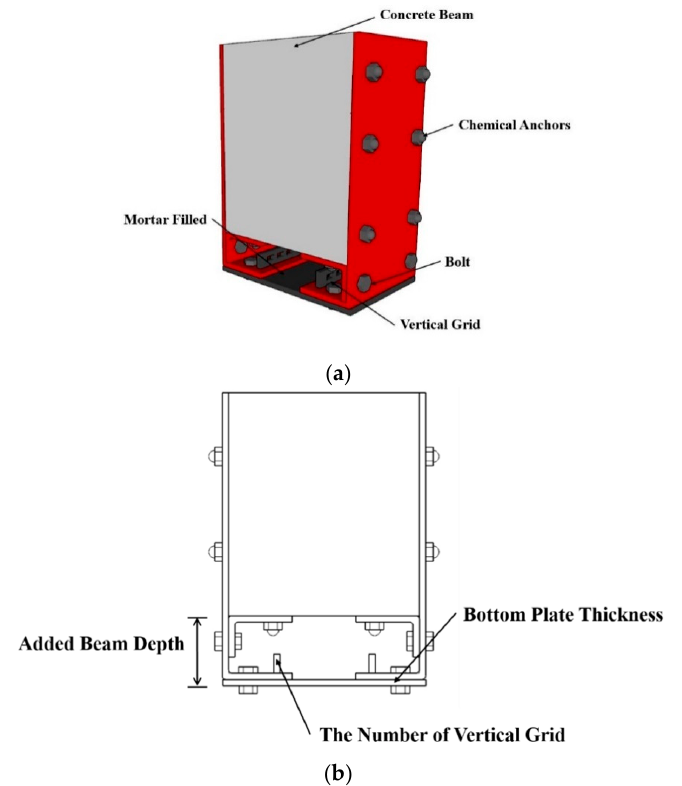
Figure 6. The test parameters: ( a ) The fabrication of proposed retrofitting system in the experiment; ( b ) test